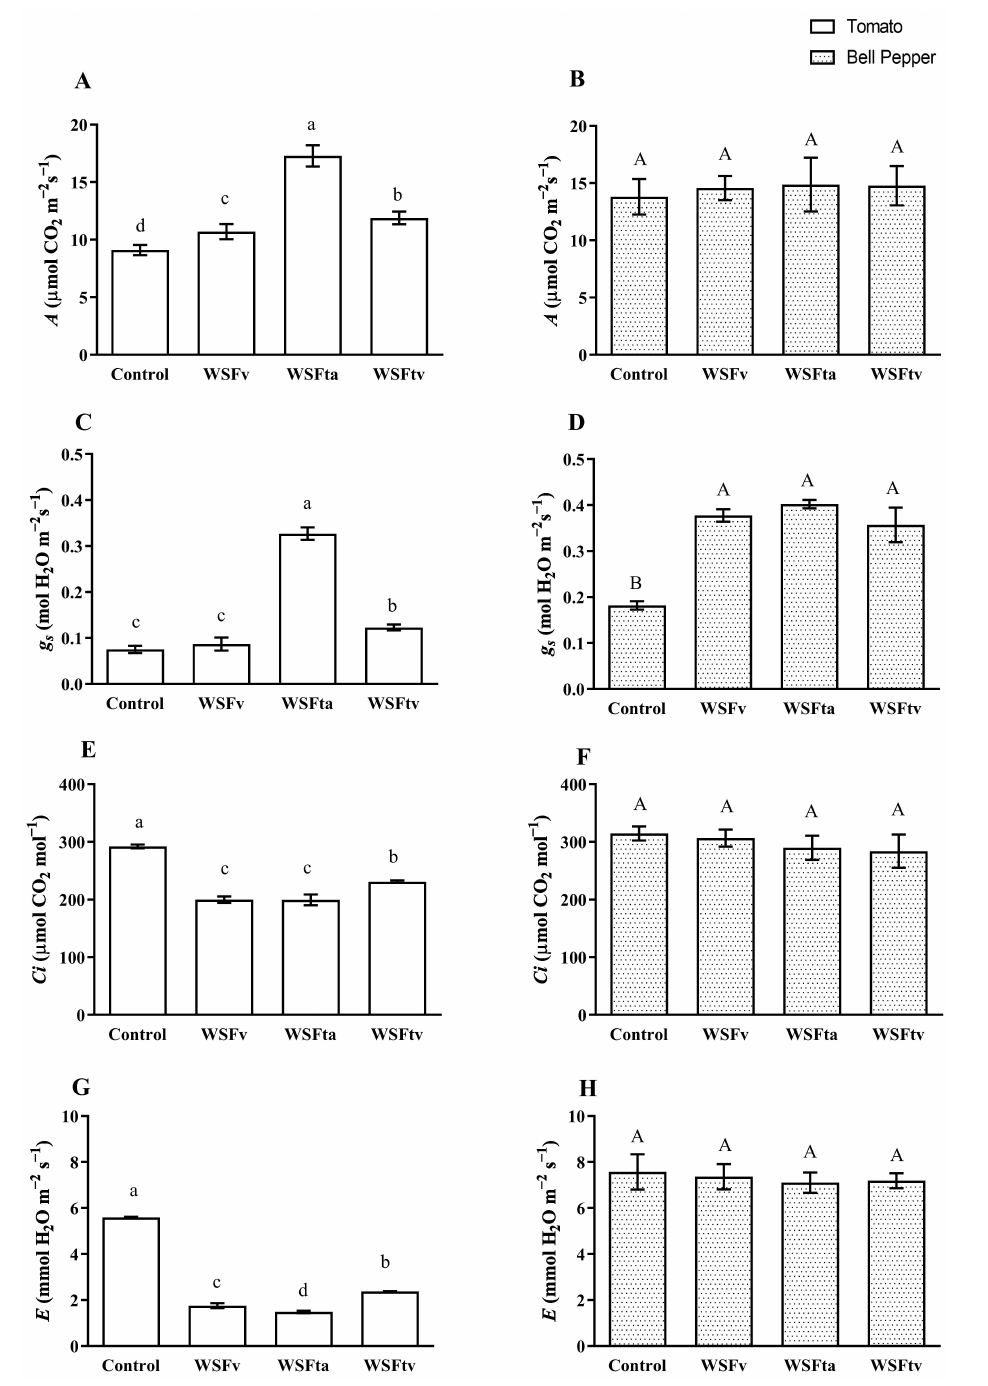
Figure 1. Photosynthetic rate ( A ) ( A , B ), stomatal conductance (gs) ( C , D ), internal CO 2 concen- tration (Ci) ( E , F ) and leaf transpiration ( E ) ( G , H ) in Meloidogyne incognita infected tomato and bell pepper plants treated with water-soluble fraction from vermicompost enriched or not with Trichoderma asperellum and T. virens . Lowercase letters and upper letters represent (LSD, p < 0.05) the effects of treatments for tomato plants and bell peppers plants, respectively. Bars represents means ± standard